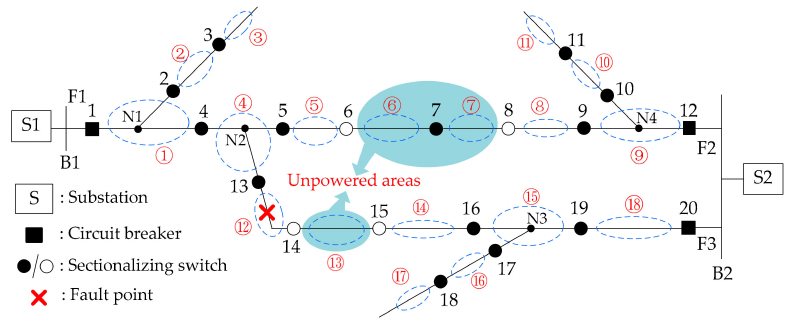
Figure 10. Operate with unpowered